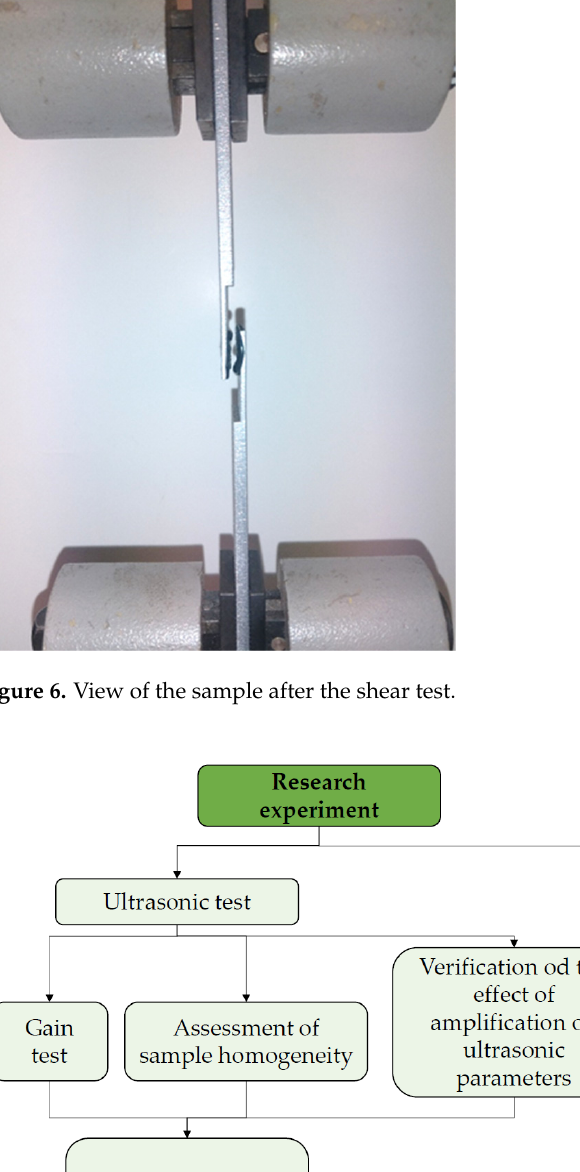
Figure 7. Plan of the research.